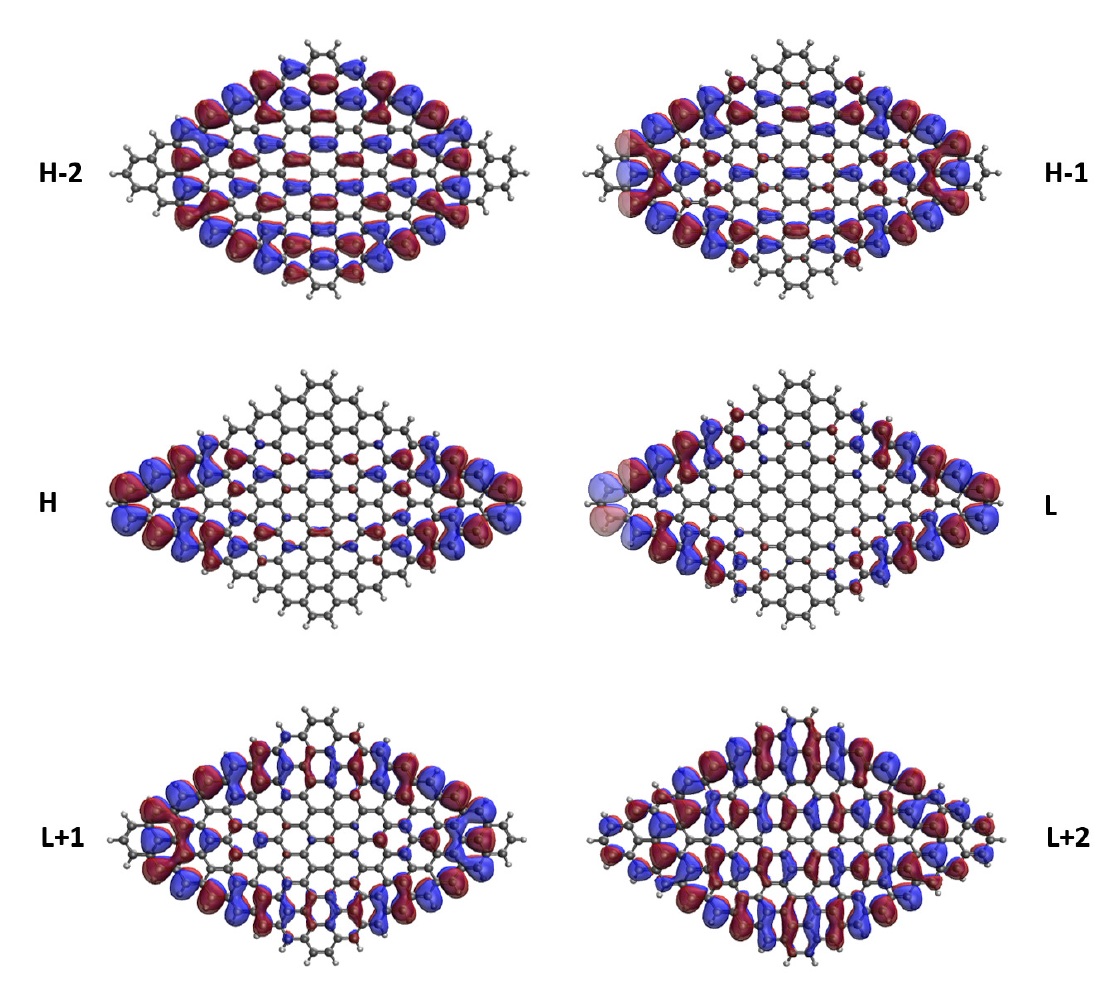
Figure 11. Real-space representation of H − 2 (1.404), H − 1 (1.141), H (1.028), L (0.992), L+1 (0.895), and L+2 (0.576) of ground-state 8-pyrene, calculated by spin-restricted TAO-LDA. Here the isovalue is 0.02 e/Å 3 . The occupation numbers of active orbitals are given in parentheses, and HOMO/LUMO is denoted as H/L for